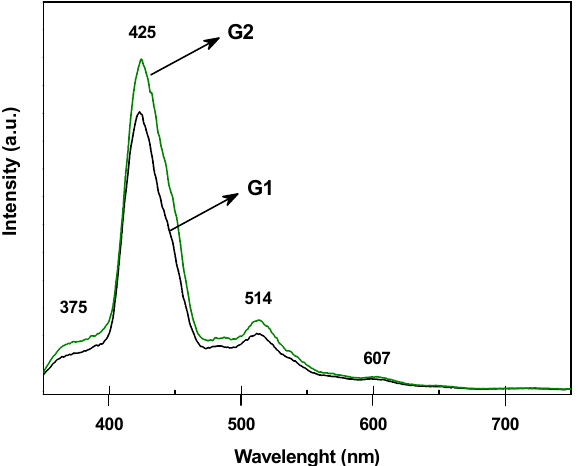
Figure 9. PL spectra of plant-mediated ZnO powders.